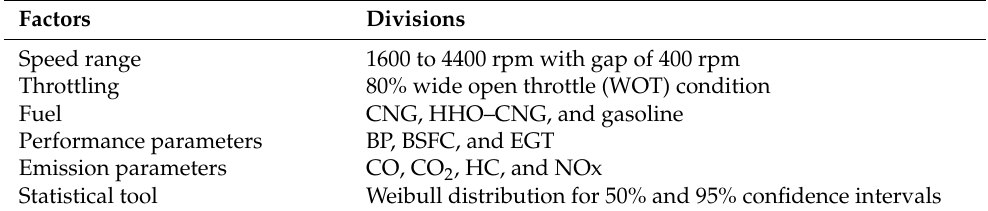
Table 3. Comprehensive empirical strategy.